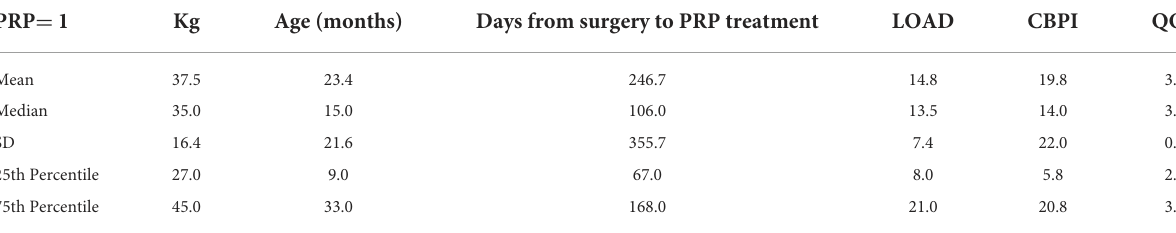
TABLE 3 Summary of patients who received PRP (PRP).